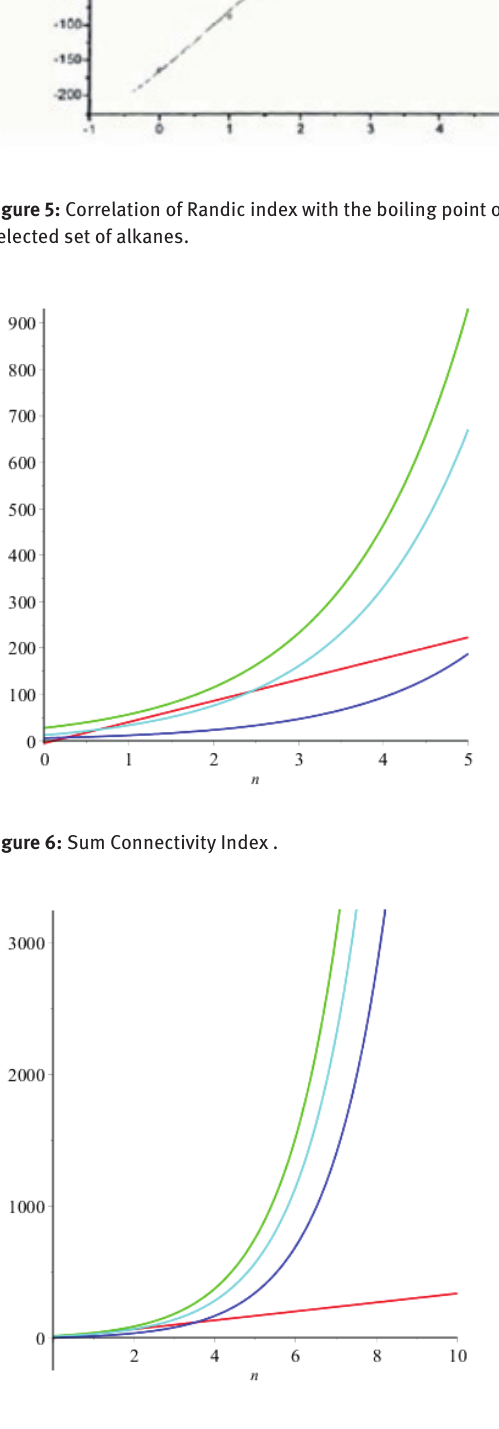
Figure 7: Modify Randic